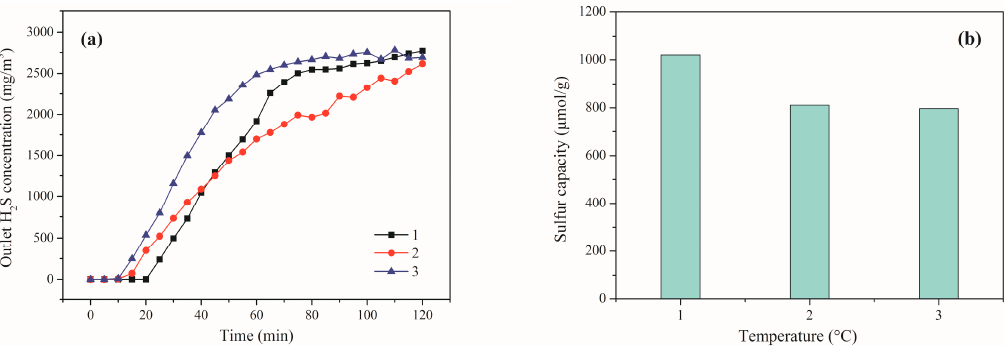
Figure 7. ( a ) H 2 S breakthrough curves and ( b ) sulfur capacities of 3 successive desulfurization and regeneration cycles over 5Fe5Ce/ZSM-5 (desulfurization: 600 °C; 30,000 mL·h − 1 ·g − 1 ; 0.2% H 2 S/N 2 ; regeneration: 600 °C; 30,000 mL·h − 1 ·g − 1 ; 5% O 2 /N 2 ).